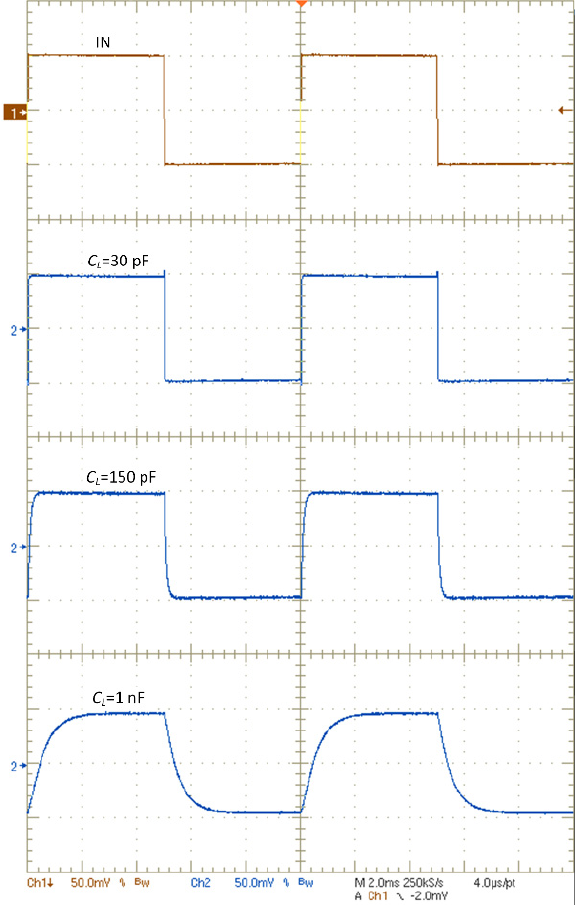
Figure 5. Measured step response in unity gain configuration for different capacitive loads. Table 2. Average main performance parameters over 10 samples for C L = 150 pF.